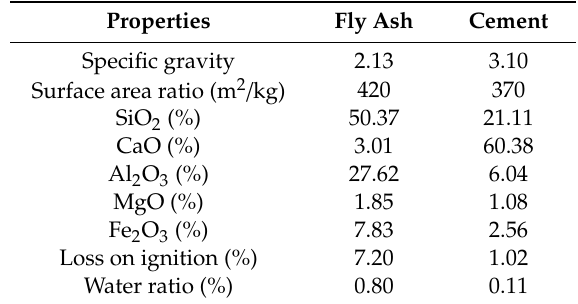
Table 1. Main components and properties of cementitious binders.